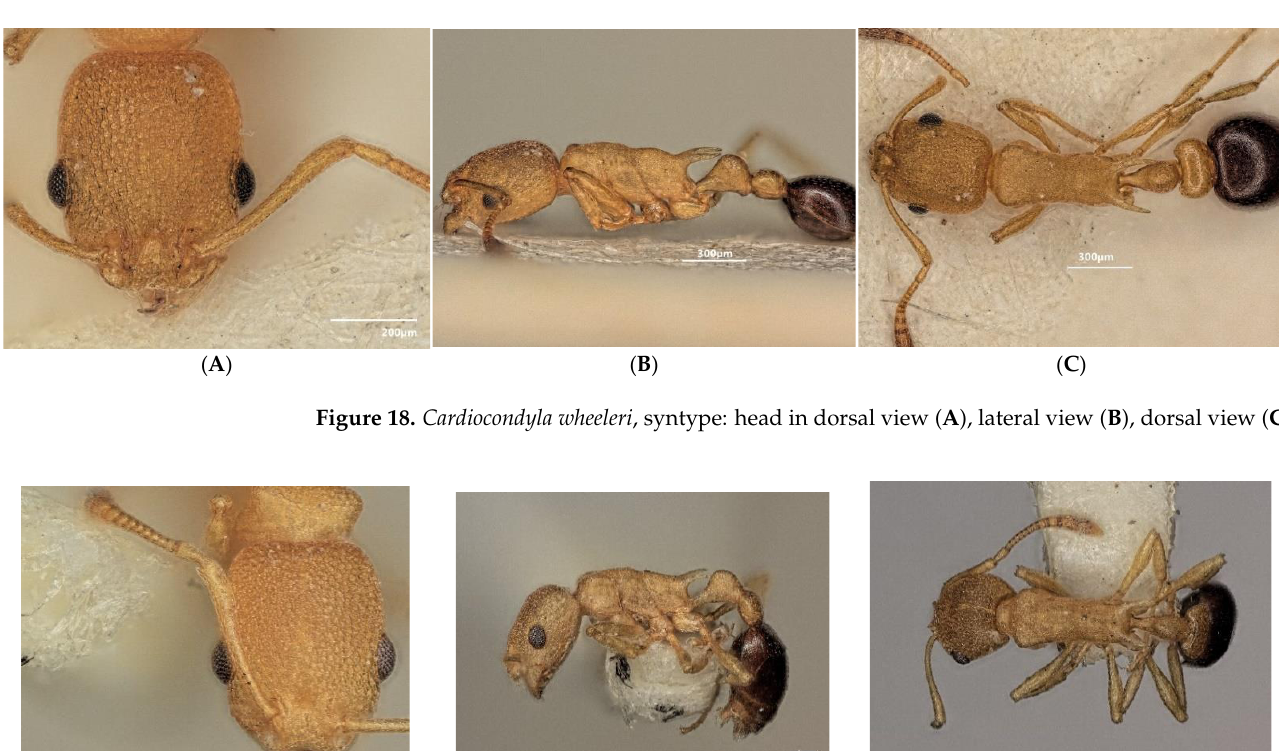
Figure 17. Cardiocondyla allonivalis n.sp., holotype: head in dorsal view ( A ), lateral view ( B ), dorsal view ( C ), waist in frontolateral view ( D ).